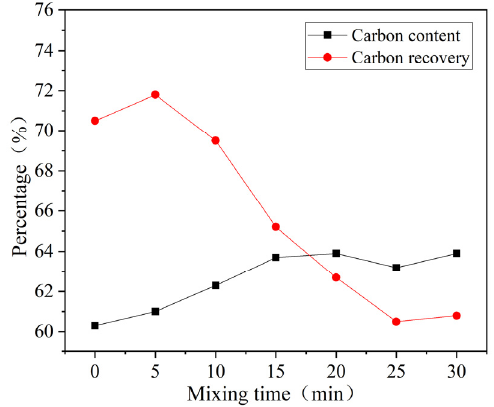
Figure 12. Effect of mixing time on flotation.